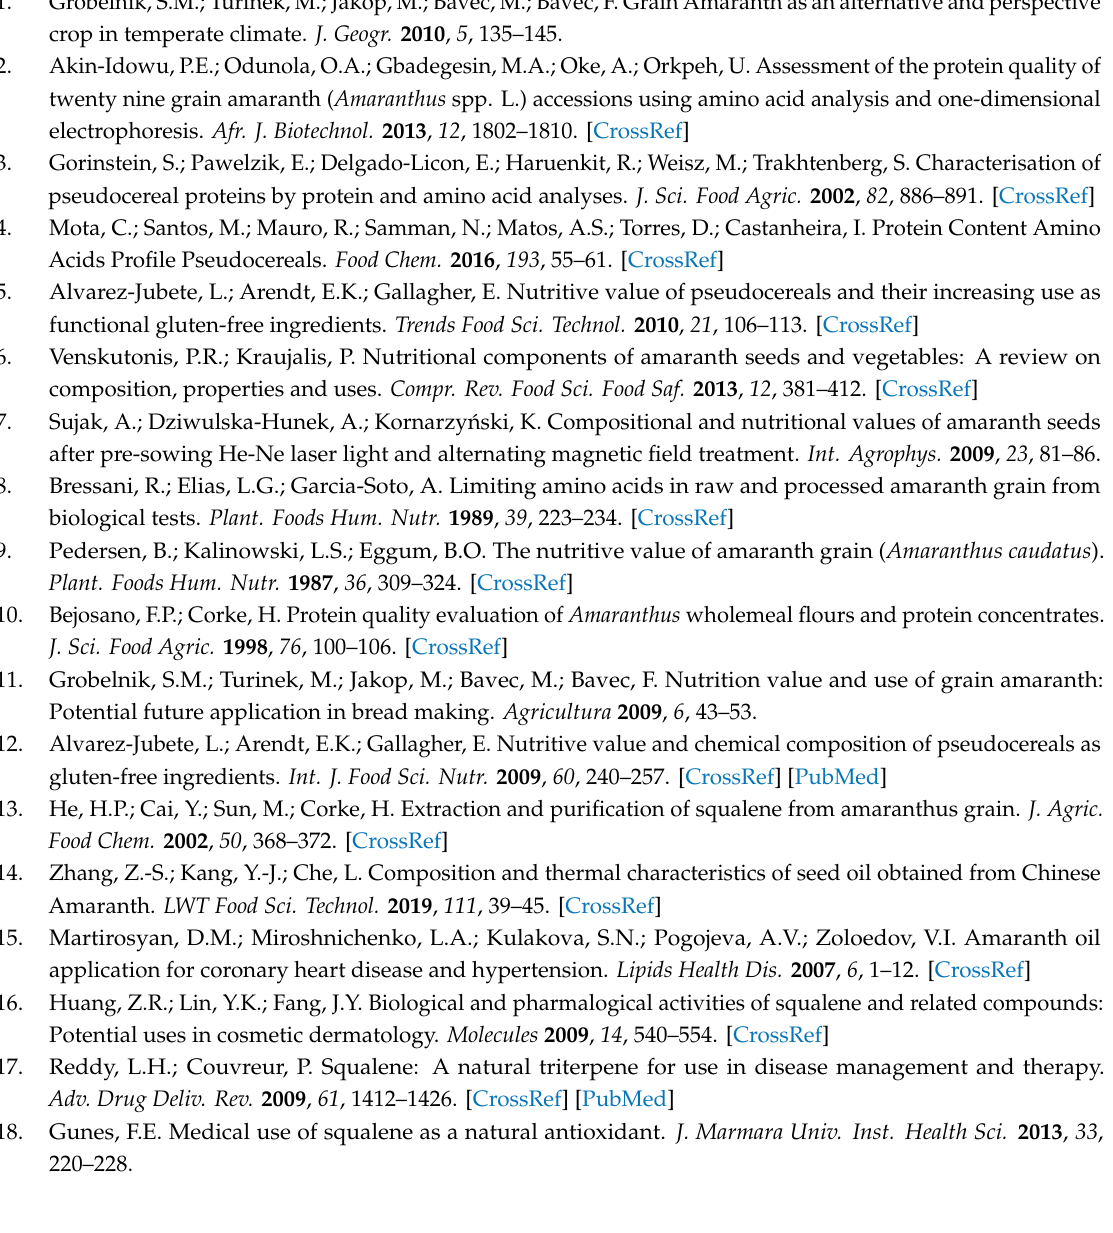
Table S1: The 1000-seed weight of amaranth samples during three year period. Figure S1: Meteorological conditions during the amaranth cropping season from 2016–2018 in locality